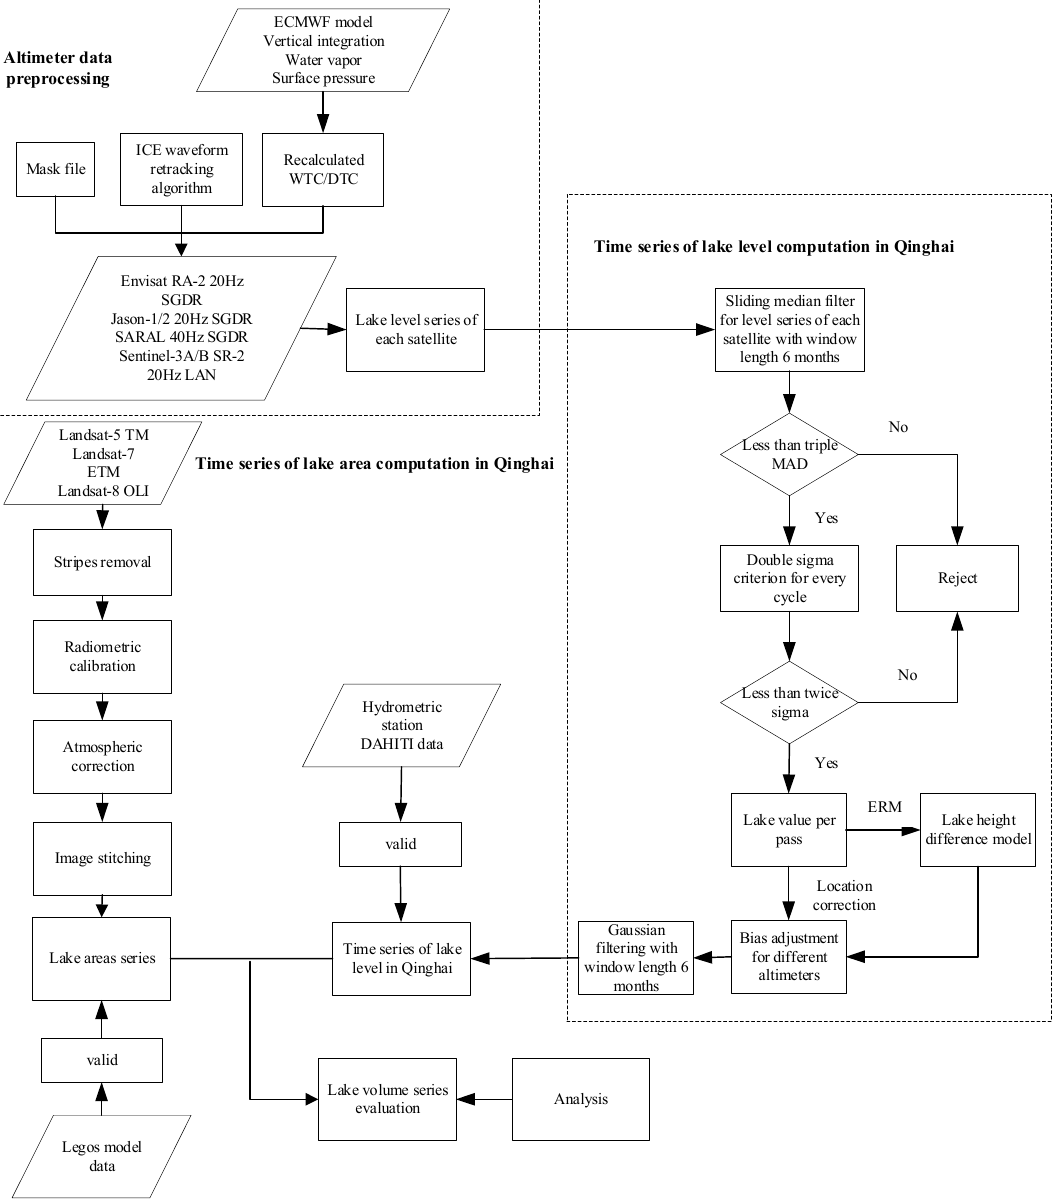
Figure 2. Data processing of LQ water storage